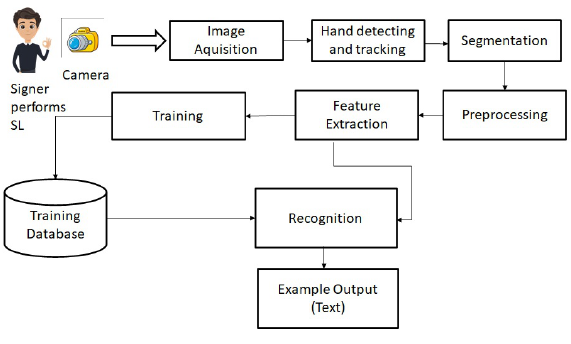
Figure 2. Proposed